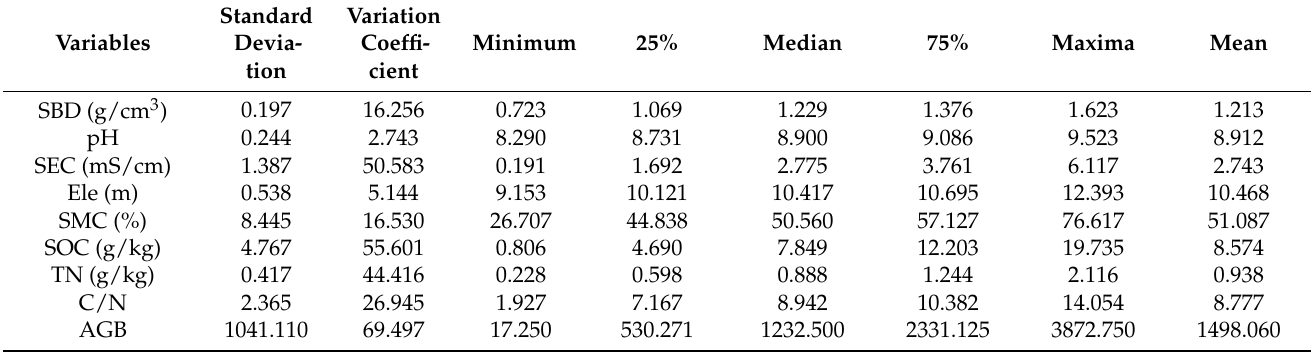
Table 1. Summary of statistical parameters of of soil physico-chemical factors.